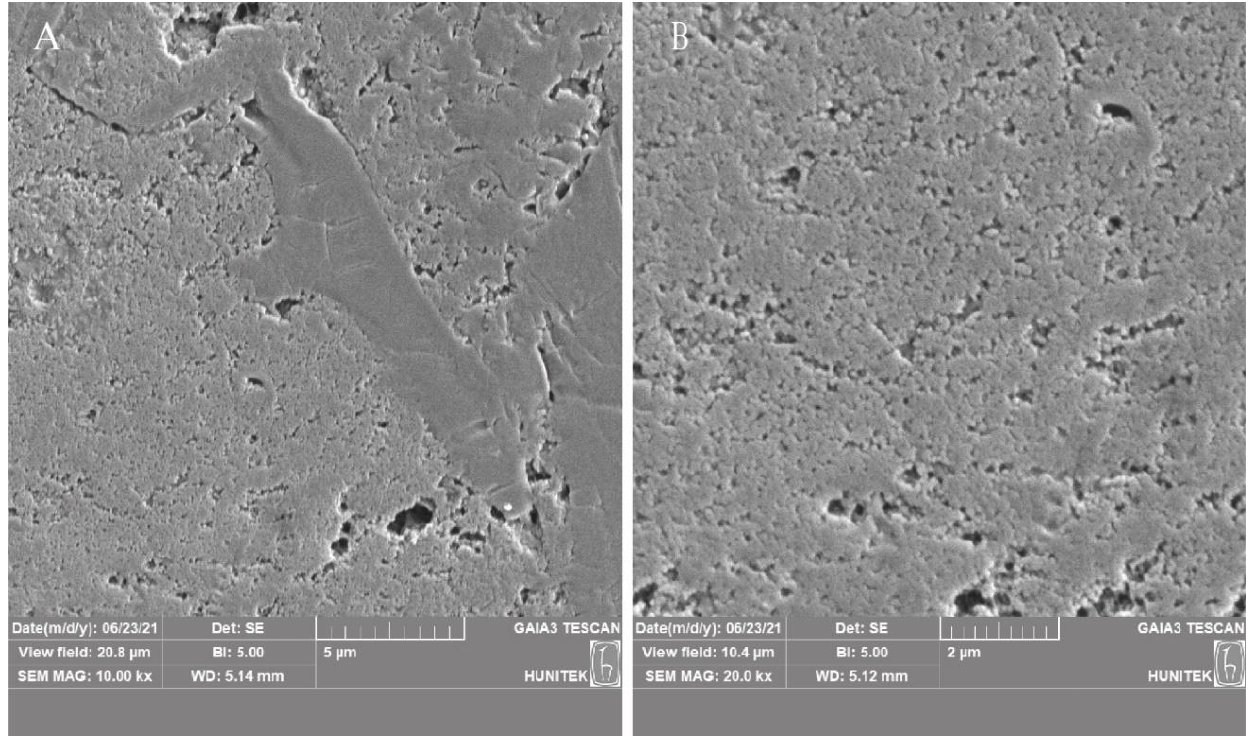
Figure 3. CIP-SPR nanosensor SEM images, ( A ) 10.00 kx mag, and ( B ) 20.00 kx mag.